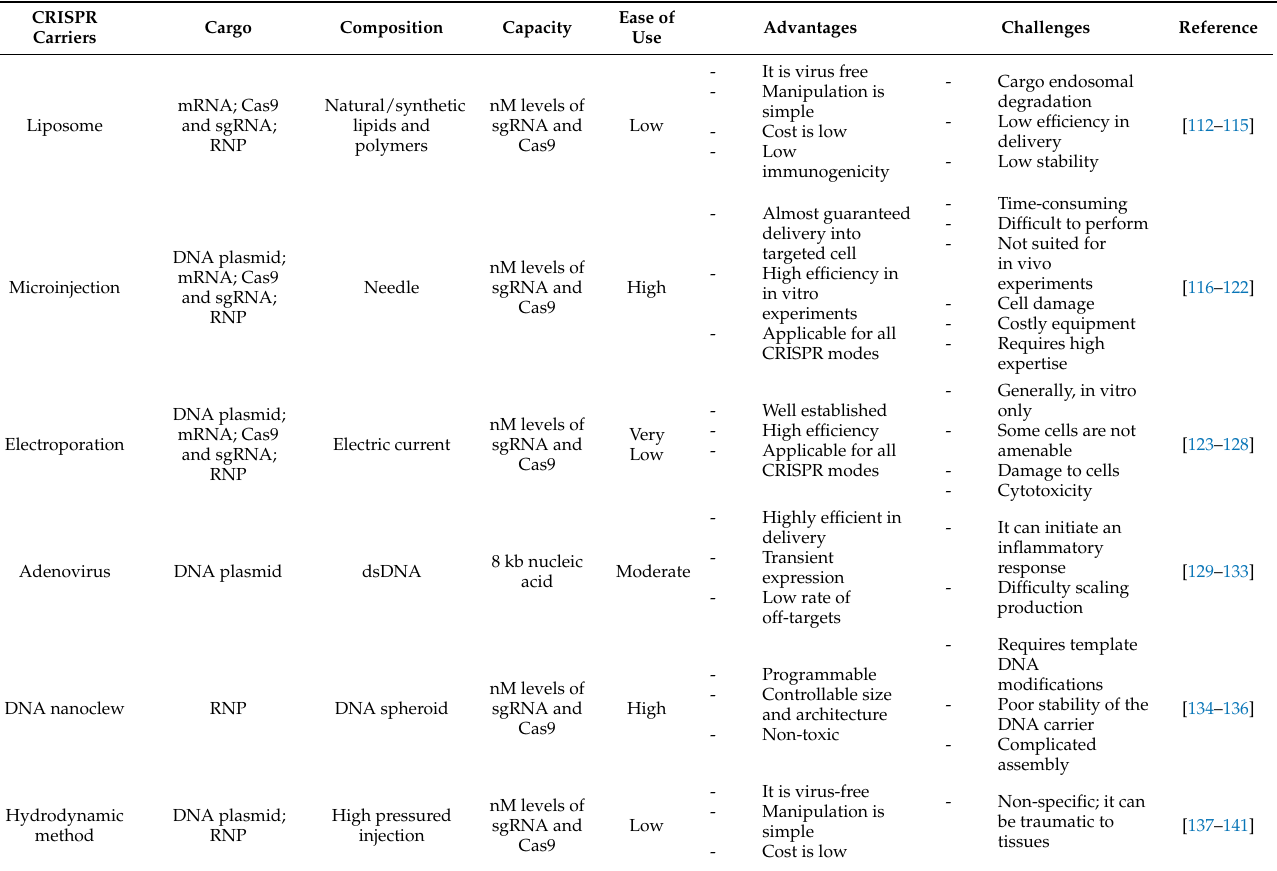
Table 2. Comparison of exosomes/liposomes with other carriers of